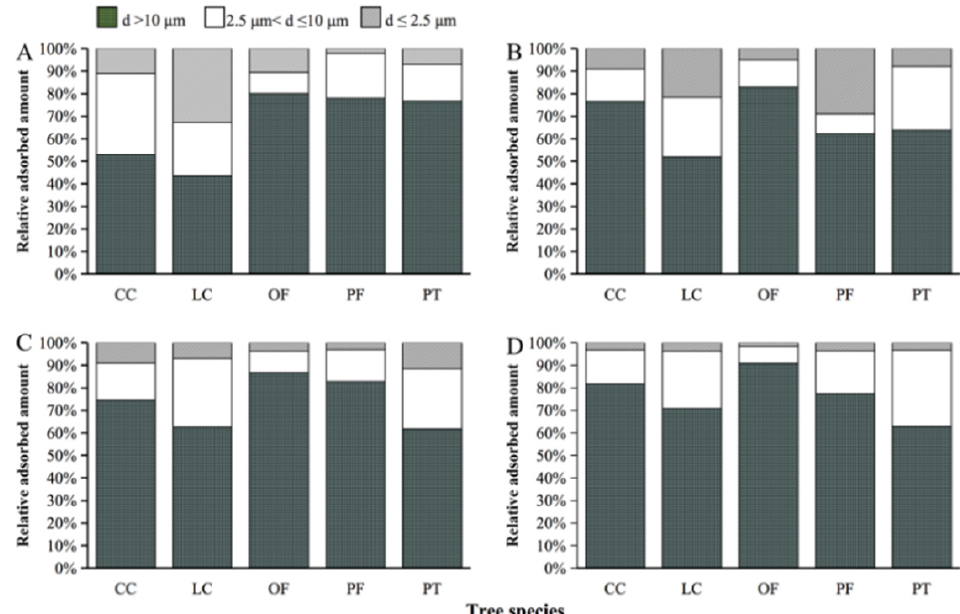
Figure 3. Size distribution of particulate matter deposition on the leaf of five plants. Note: ( A ) spring, ( B ) summer, ( C ) autumn, ( D ) winter; CC: Cinnamomum camphora (L.) Presl; LC: Loropetalum chinense var. rubrum Yieh; OF: Osmanthus fragrans (Thunb.) Loureiro; PF: Photinia × fraseri Dress; PT: Pittosporum tobira (Thunb.) Ait .